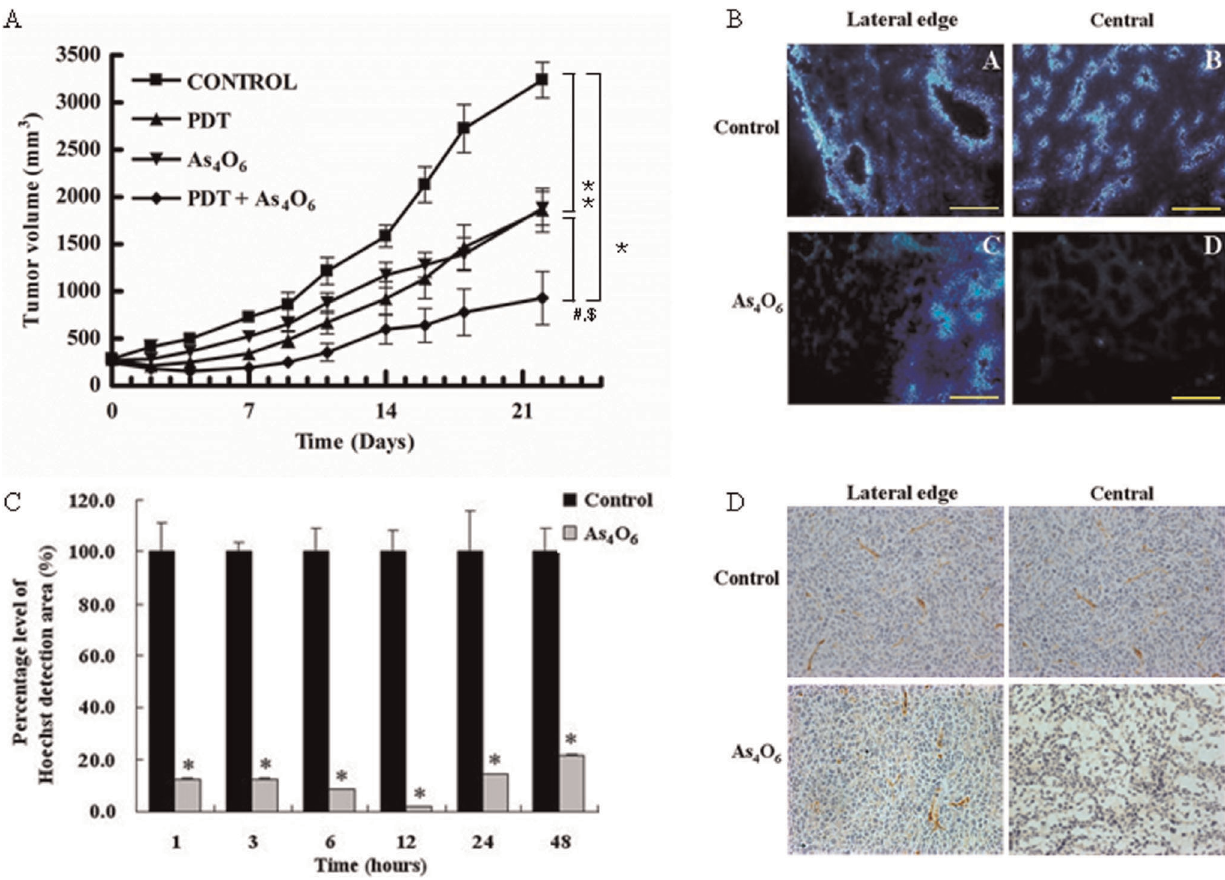
Figure 5. Invivo effect of the combination of As 4 O 6 and Radachlorin/PDT on tumor growth inhibition in TC-1 cell-challenged C57BL/ 6 mice. (A) Tumor growth curves for TC-1 of mice treated with Radachlorin/PDT and/or As 4 O 6 (n=7 for each group). Tumor bearing mice were given intravenously injected Radachlorin (10 mg/kg b.w.) and/or peritoneal injections of 7.5 mg/kg of As 4 O 6 . Three hours later, cells were exposed to laser, tumor size was monitored thereafter, as described in Materials and Methods, and its mean ellipsoid volume was plotted over time. Significant inhibition of tumor growth was detected by ANOVA. *: P , 0.01, compared with the control group, # : P , 0.01, compared with the Radachlorin/PDT alone group and $: P , 0.01, compared with the As 4 O 6 alone group. (B) Perfusion and morphological changes in TC-1 tumors in C57BL/6 mice treated with As 4 O 6 (10 mg/kg b.w., i.p.). Tumor tissues were harvested after 48 h after As 4 O 6 treatment. Tissue were viewed at a wavelength of 365 nm and photographed at x200 magnification. (C) Percent area of perfusion area of TC-1 tumors in C57BL/6 mice treated with As 4 O 6 compared with non treated tumors. The tumor tissues were harvested at indicated times after As 4 O 6 treatment. Sequential changes of perfused areas at 1, 3, 6, 12, 24, and 48 hr after As 4 O 6 treatment. * P , 0.05, compared to untreated controls. (D) CD31-immunostained tumor sections (original magnification, x400)